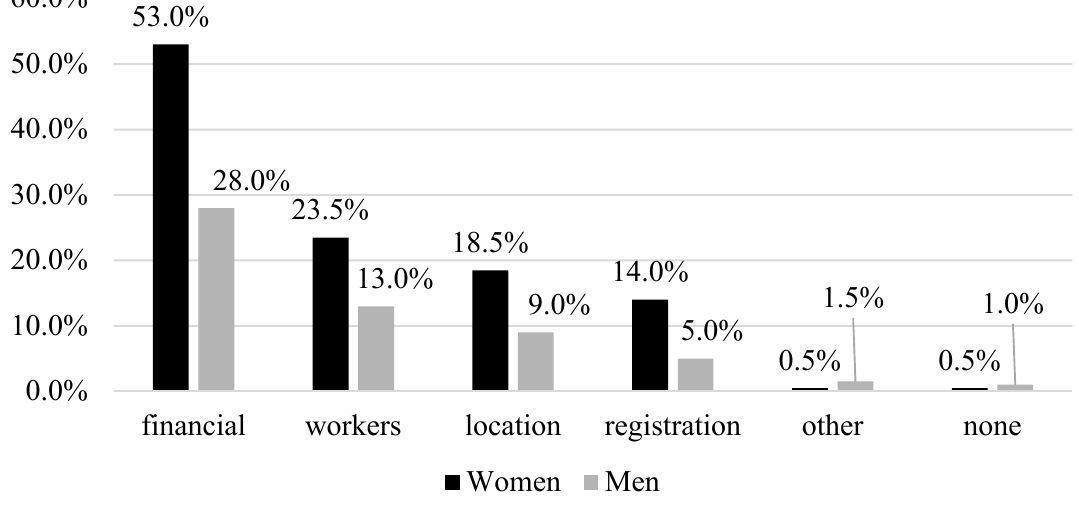
Figure 2. Barriers to setting up their own business according to women and men [%]. Source: Own research.